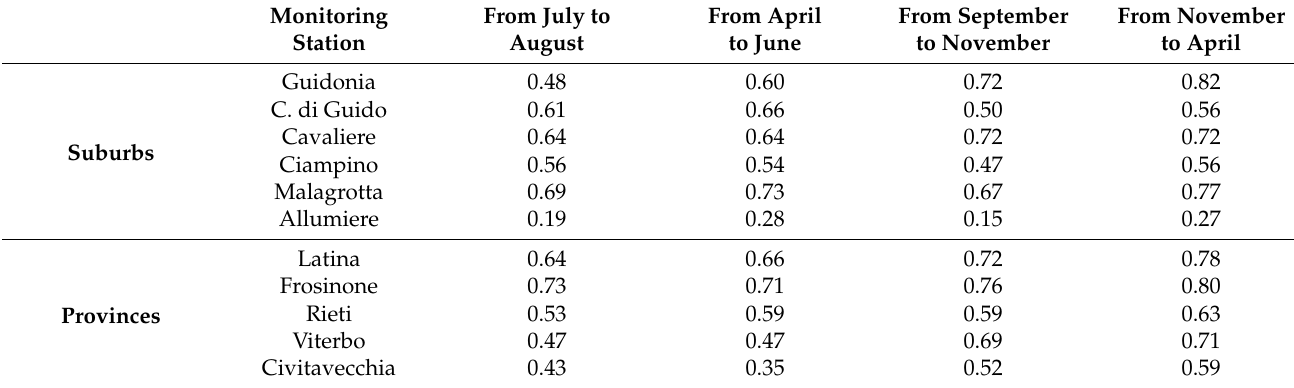
Table 6. Cross-correlation values between Roma Green Band and suburbs or province stations of [NO X ] in 2015. Monitoring